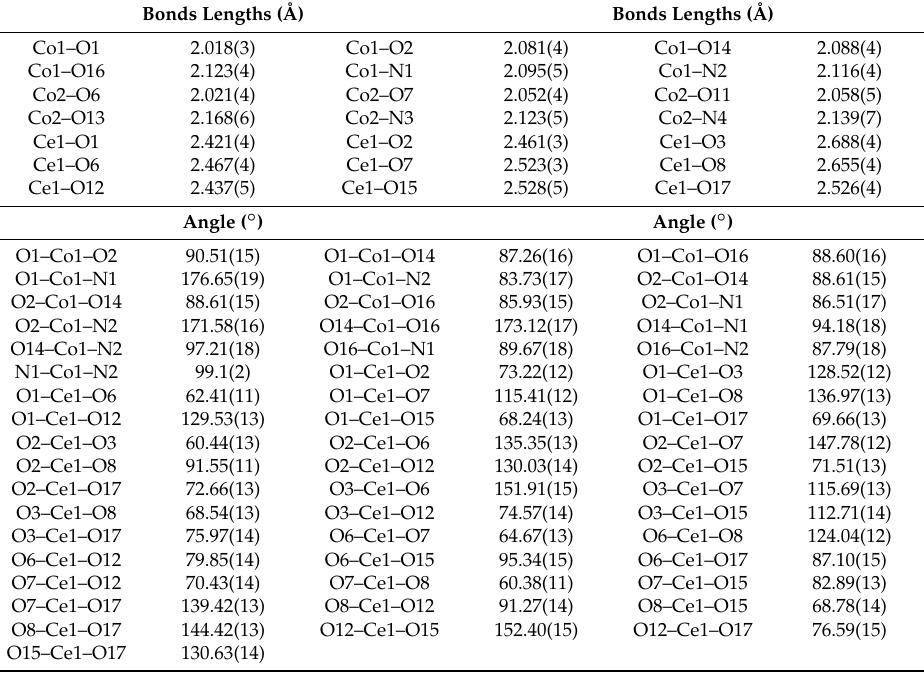
Table 3. Selected bond lengths (Å) and angles ( ◦ ) for the Co(II)-Ce(III) complex.